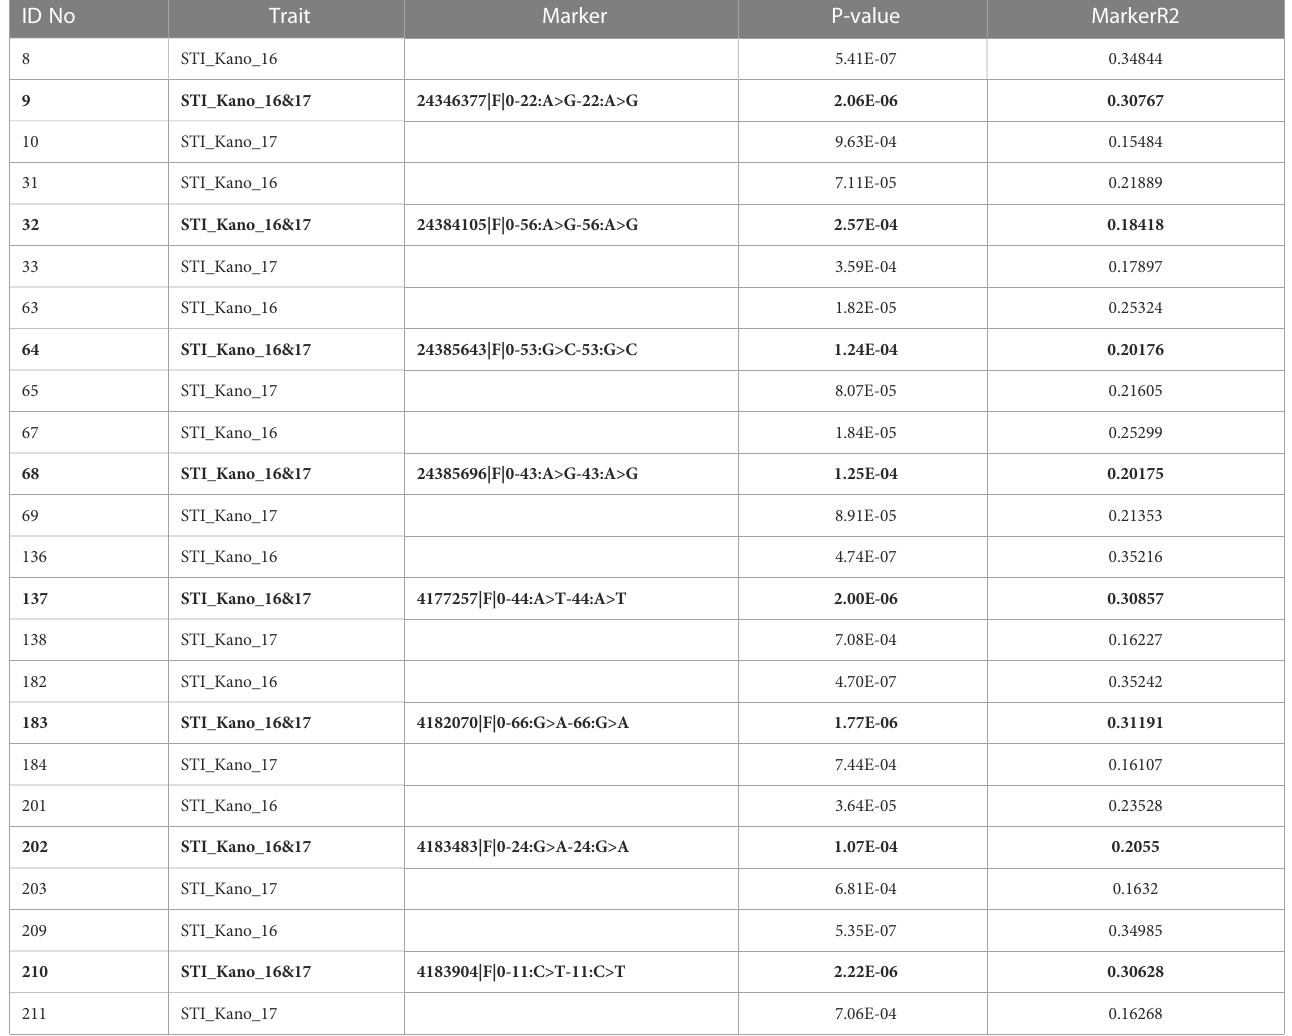
TABLE 5 Summary of the eight diagnostic